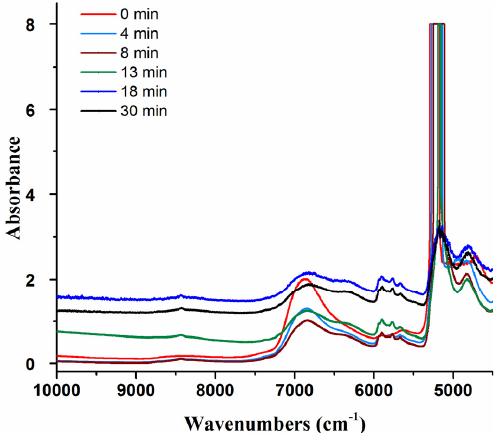
Figure 2. The NIR spectra during the process under normal operating